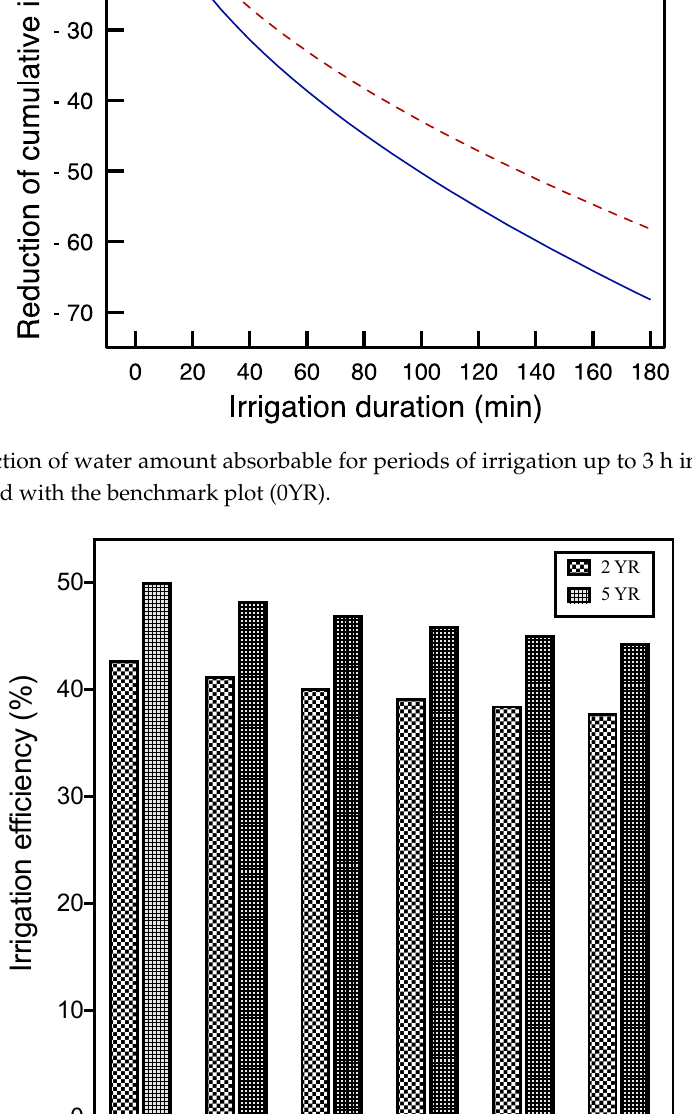
Figure 5. Irrigation efficiency obtained in 2YR and 5YR plots for periods of irrigation up to 3 h in terms of cumulative infiltration reduction if compared with the benchmark plot (0YR).